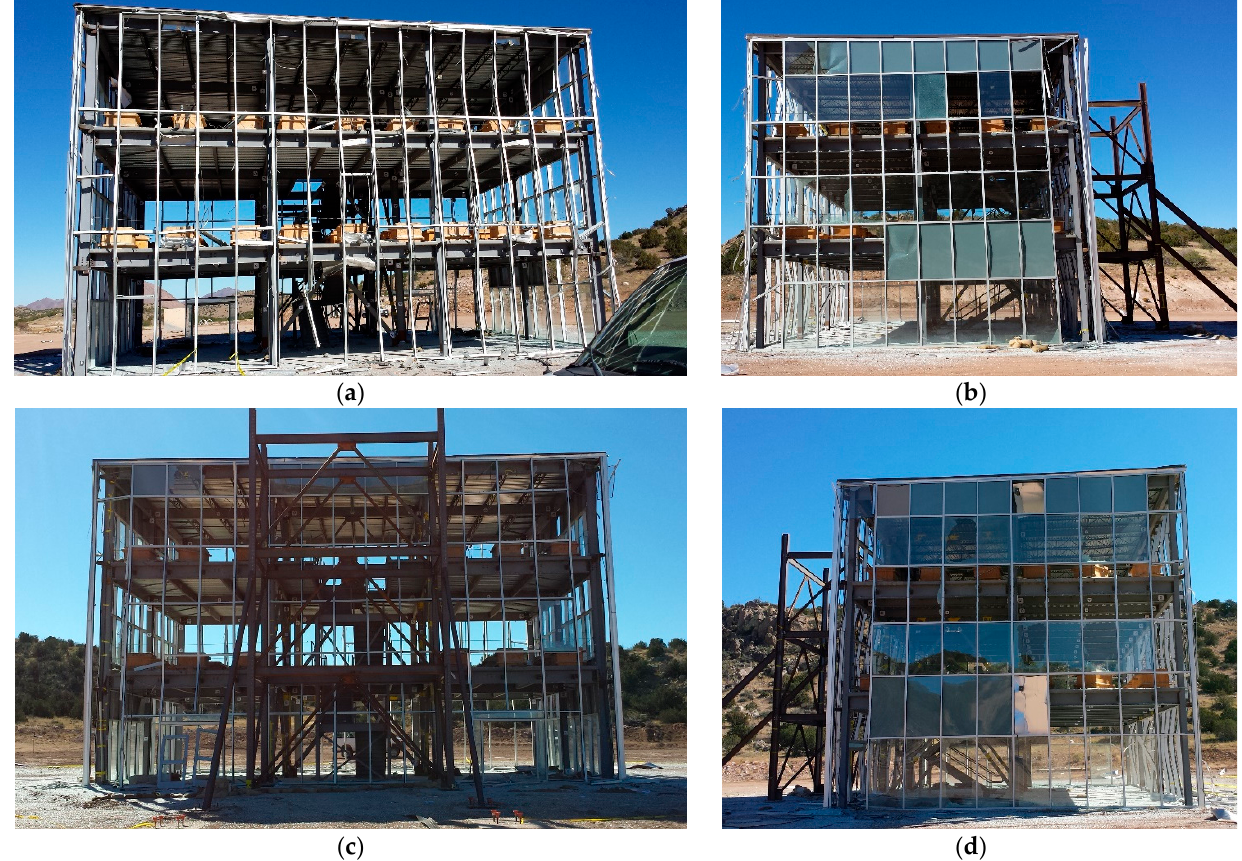
Figure 13. Test 1—Post-test condition of structure: ( a ) Front (south) elevation; ( b ) Side (east) elevation; ( c ) Rear (north) elevation; ( d ) Side (west) elevation.